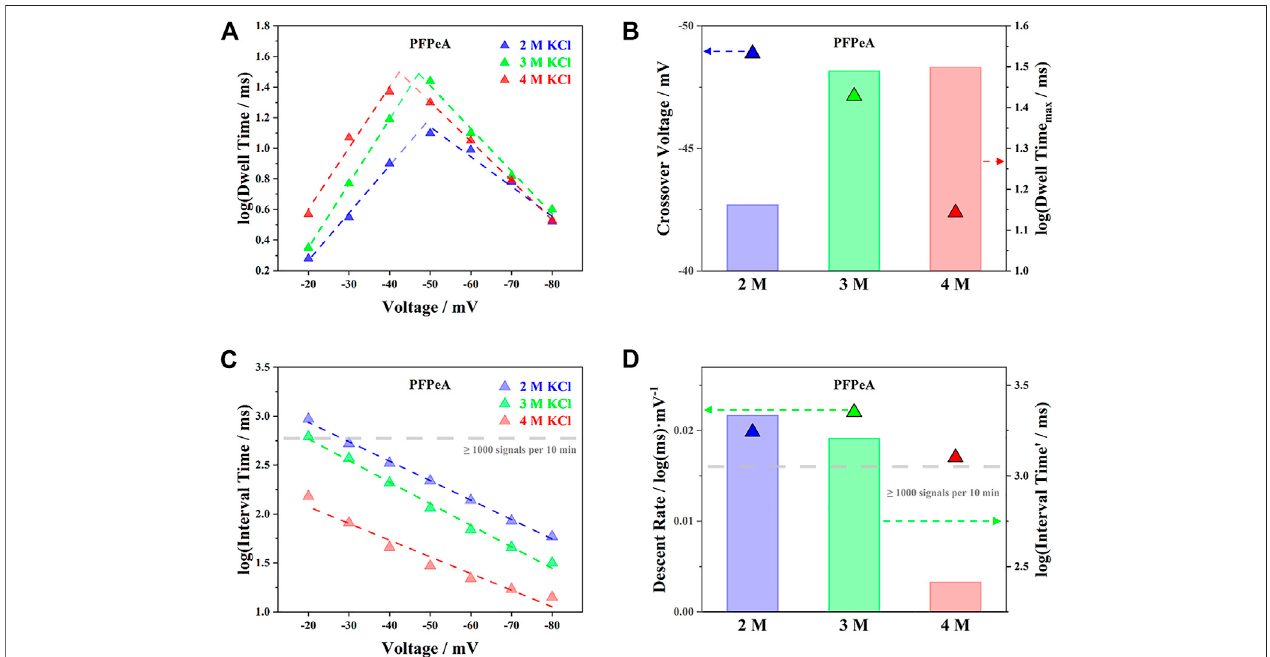
FIGURE 3 | In fl uence of electrolyte concentration on (A) voltage-dependent dwell time of PFPeA, (B) cross-over voltage and theoretical maximum dwell time, (C) voltage-dependent dwell time of PFPeA, and (D) its slope (descent rate) and intercept (interval time at 0 mV).